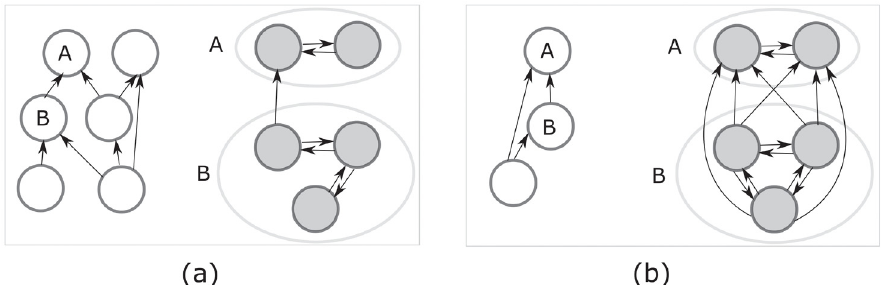
Fig 3. Examples of hierarchical structures. Consider each subfigure, (a) and (b), as an example of a digraph G which has its condensation graph C ( G ) represented by the graph with white-colored nodes on the left, and which has a subgraph corresponding to the nodes A and B of C ( G ) represented by a graph with gray-colored nodes on the right. In (a) we have a particular example of a hierarchical structure which is not a sequential hierarchy, whereas in (b) we have a hierarchical structure which is a sequential hierarchy. In both cases, all agents corresponding to node A in C ( G ) have level 2, whereas all agents corresponding to node B in C ( G ) have level 1.